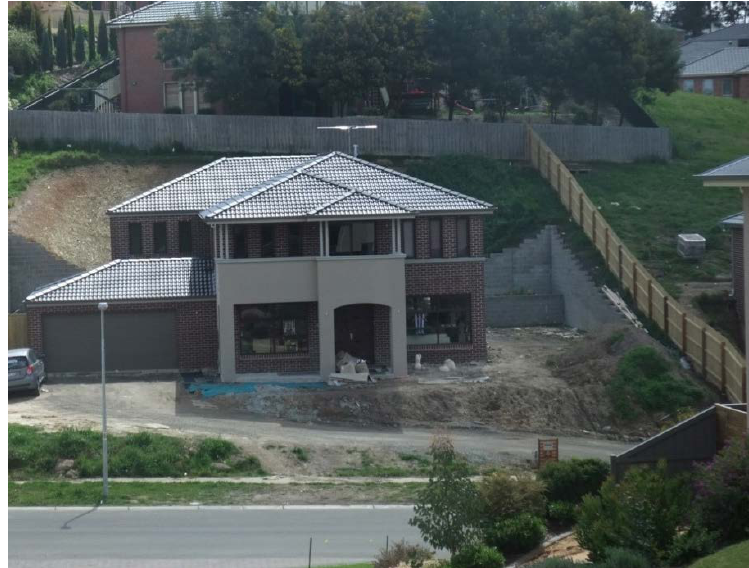
Figure 1: Example of a new residence under construction on a steeply sloping site (Note: Photograph attributed to Alistair